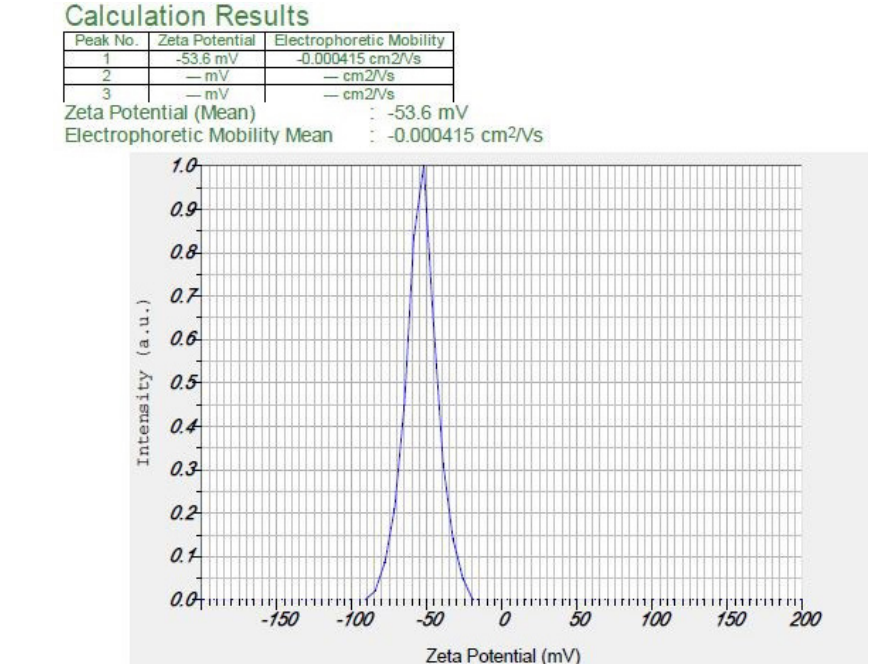
Figure 6. Zeta Potential of a Nano-system Containing the Licorice Extract.